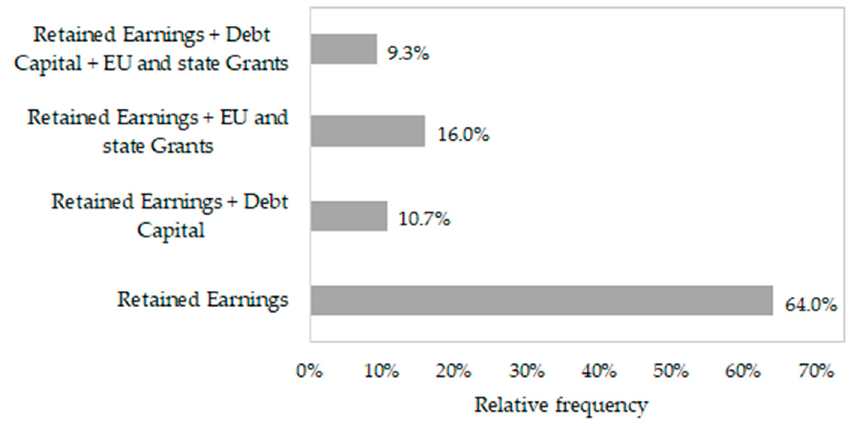
Figure 5. Family businesses' financial resources for innovation activities.